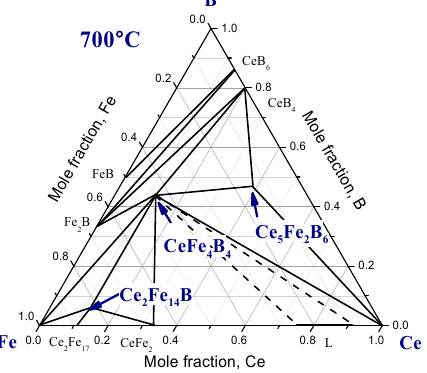
Figure 1. Isothermal section of Ce-Fe-B system at 700 °C [8].